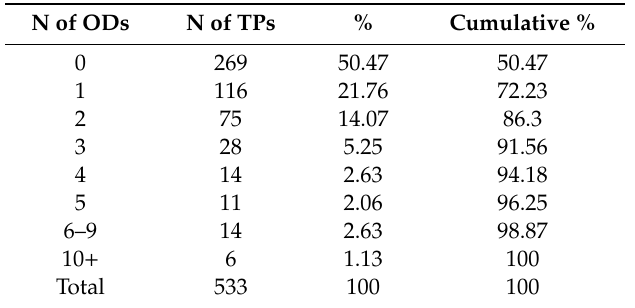
Table 2. Number of ODs in Thiessen Polygons in the Study Area, 2015–2019. N of ODs N of